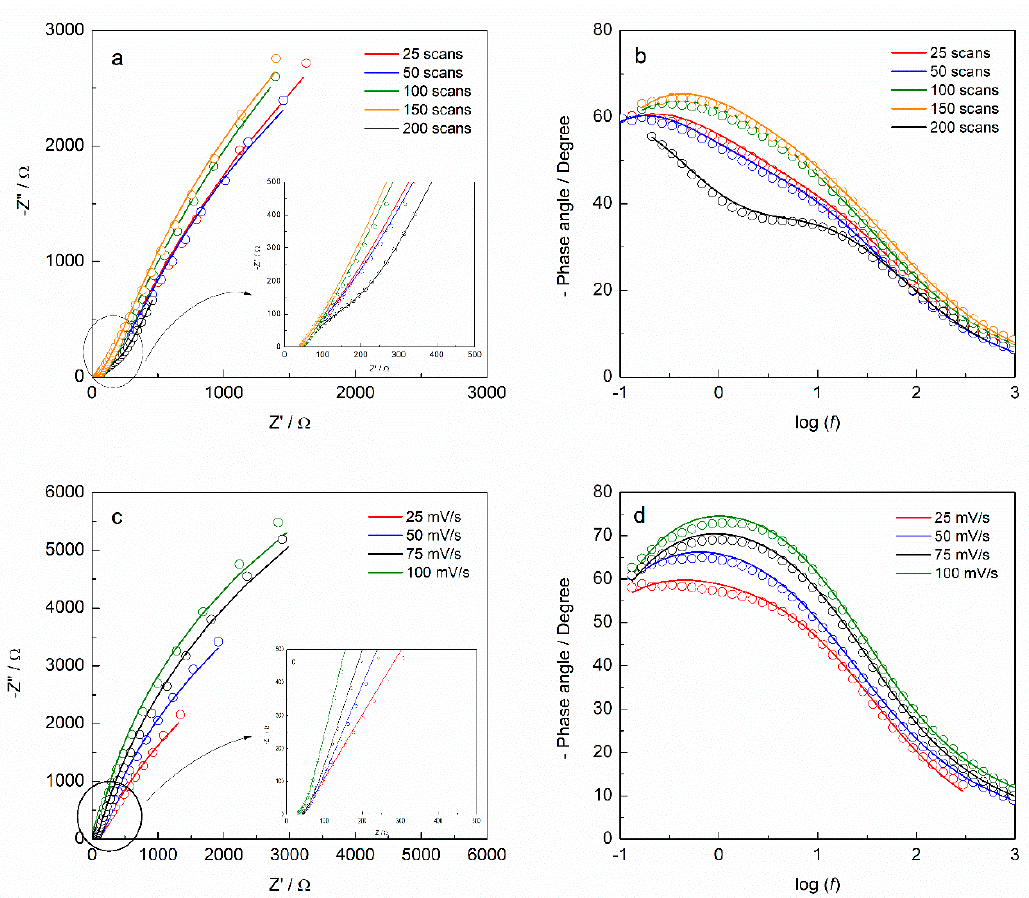
Figure 4. Nyquist ( a – c ) and Bode ( b – d ) diagrams for poly(4-HPA)/GE obtained in 5.0 mM K 4 [Fe(CN) 6 ]/K 3 [Fe(CN) 6 ] containing 0.10 M KCl. ( a , b ) the electrodes modified with 25, 50, 100, 150, and 200 scans. ( c , d ) poly(4-HPA)/GE platforms modified at 25, 50, 75, and 100 mV/s. Amplitude 10 mV; frequency range: 10 6 to 10 − 2 Hz. Solid lines represent the circuit’s fit to the experimental data. An equivalent circuit described as R s (Q dl R ct )(Q f [R f W]) was used for experimental data simulation